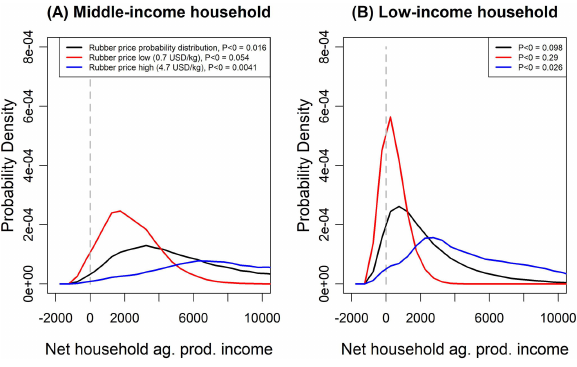
Fig. 7 . Probability distribution of net household agricultural production income when the rubber market price in China is reflected in the Bayesian network as a probability distribution (black) or set to its minimum (red) or maximum (blue) value for a (A) middle-income household and a (B) low-income household representative of both case study areas. For both household types, paddy rice area is leased for cash crop production, and upland agricultural area is planted with